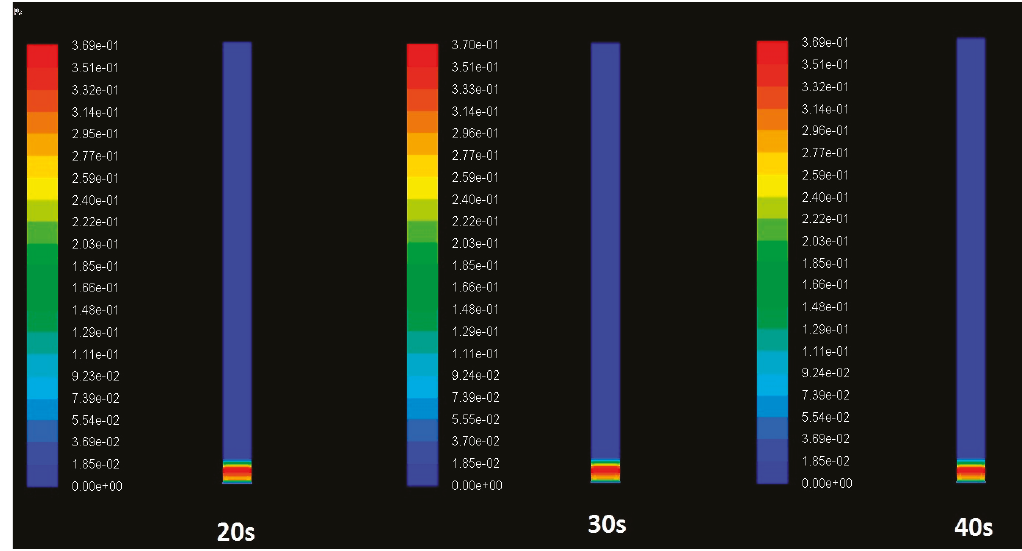
Figure 7. Solids volume fraction contour of Case 1 (20, 30, and 40 s).